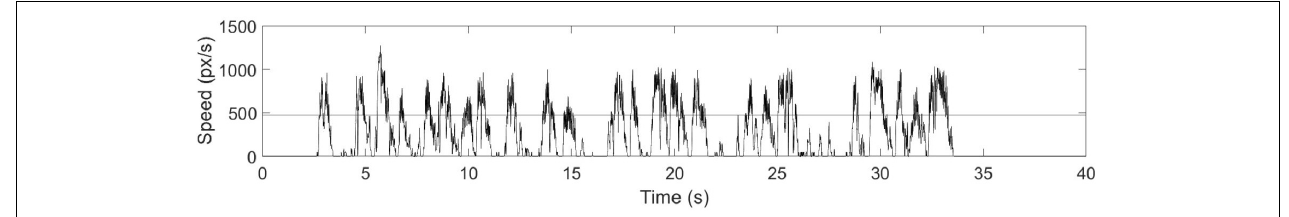
FIGURE 3 | Speed time course of the stylus during TMT-A performance, for a representative participant. Linking periods are characterized by rapid acceleration to peak stylus speed, followed by similar deceleration, whereas non-linking periods are characterized by much lower stylus speed. The horizontal line indicates the threshold separating linking and non-linking